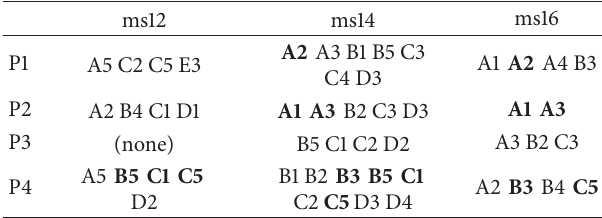
Table 5: Isolate primitives by ms